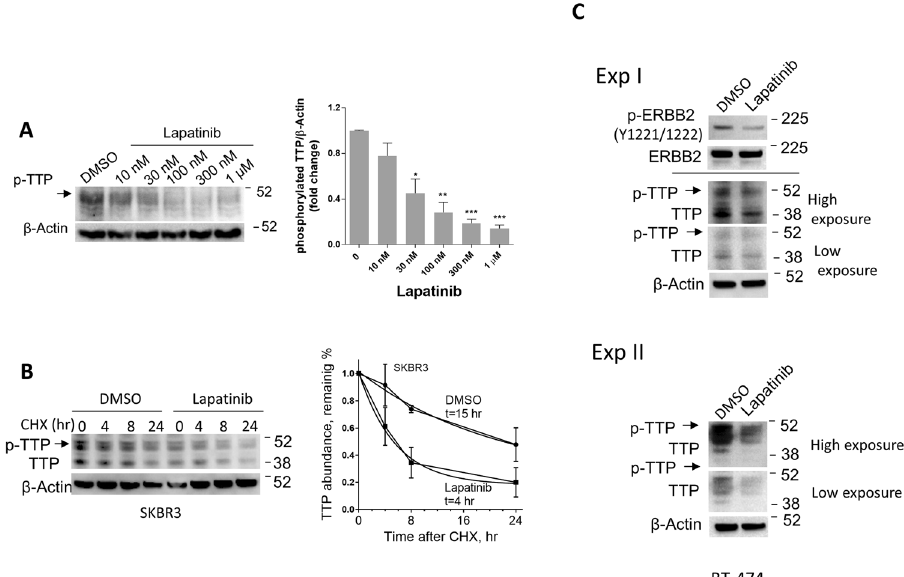
Fig. 5 Effect of ERBB2 pharmacological inhibitor on ZFP36/TTP phosphorylation. A Dose-dependent activity of lapatinib on the abundance of phosphorylated ZFP36/TTP in the ERBB2-positive SKBR3 cells. The relative amounts of the proteins from three immunoblots were quanti fi ed using Image J software ( left panel ). Fold changes (Mean ± SEM, n = 3) of phosphorylated ZFP36/TTP abundance normalized to β -Actin using Image J program (right panel). B Effect of ERBB2 inhibition on ZFP36/TTP protein stability. SKBR3 cells were treated with lapatinib (300 nM) for 16 h, followed by 10 µg/ml of cycloheximide (CHX) treatment for the indicated durations (left panel). Protein lysates were subjected to immunoblotting with anti-TTP. Right panel: quanti fi cation of ZFP36/TTP abundance, normalized to GAPDH, was determined using ImageJ software and the protein half-life was assessed using the Graph Prism. Data are mean + / − SEM of two experiments. C Effect of lapatinib on the abundance of ZFP36/TTP protein in the ERBB2-positive cells, BT-474. WB is a representative of two blots from independent